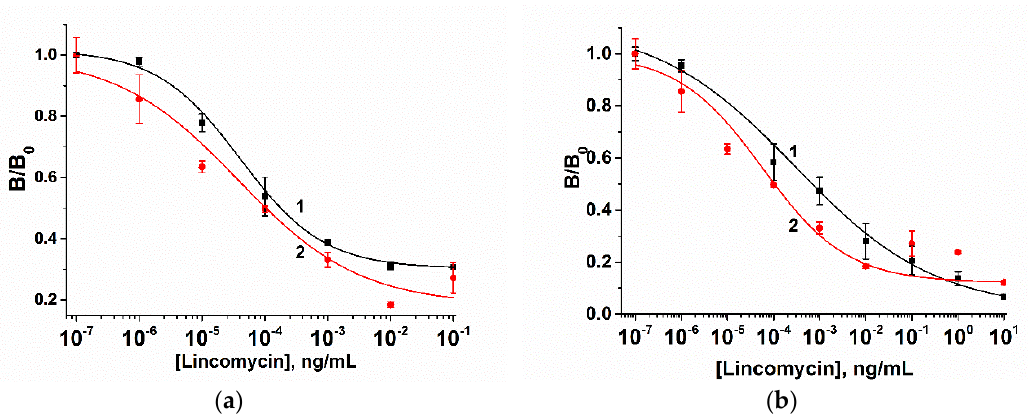
Figure 7. Calibration curves of the SERS-based LFIA of LIN for various LIN–BSA conjugate and AuNPs–MBA–Ab bioprobe amounts. ( a ) The amount of AuNPs–MBA–Ab bioprobe was 1 μ L (1) and 4 μ L (2); ( b ) the amount of LIN–BSA conjugate was 0.2 mg/mL (1) and 0.5 mg/mL (2). B and B 0 (B 0 ≈ 1000 a.u.) correspond to the SERS intensities of MBA at 1077 cm − 1 , when standard and zero LIN solutions were applied to the sample pad, respectively. The error bars indicate the standard deviations for three measurements .